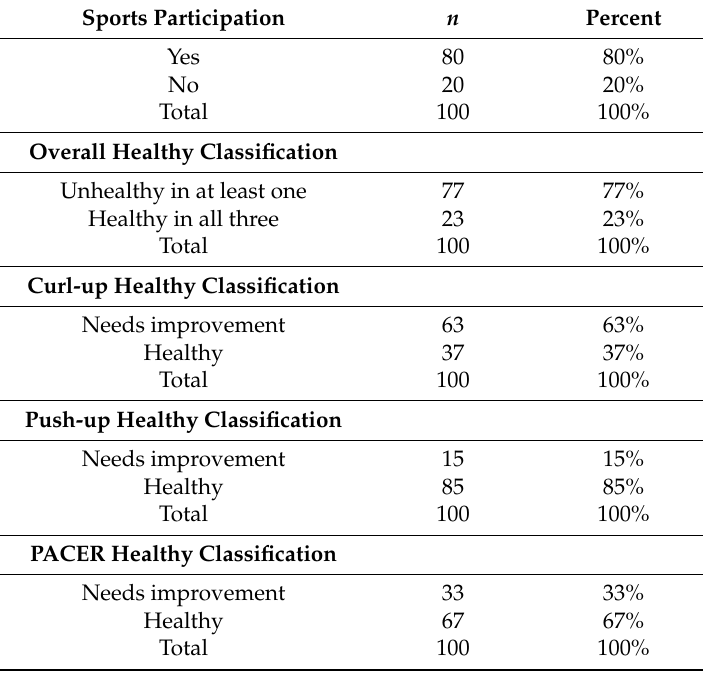
Table 3. Sports participation and healthy status